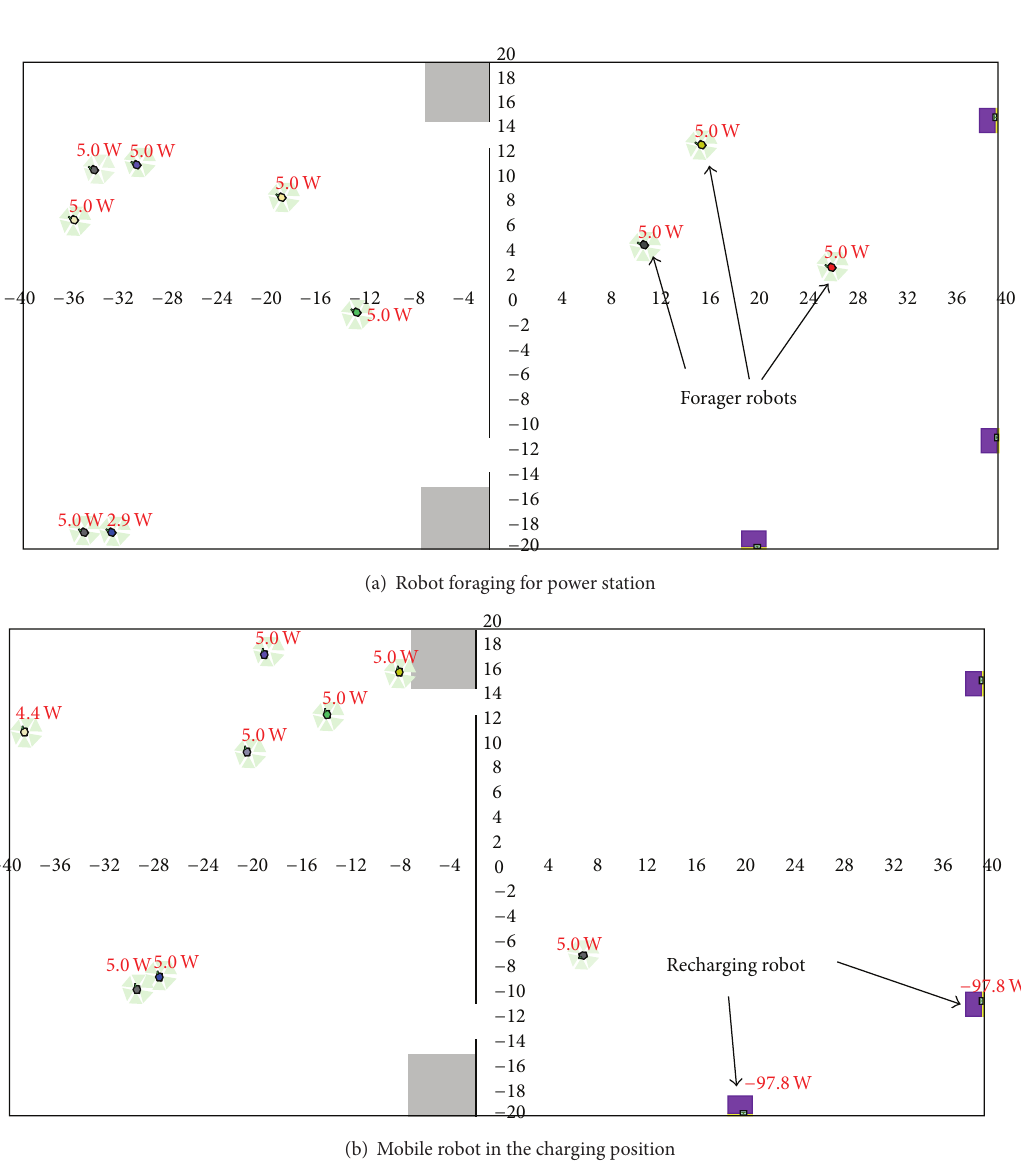
Figure 3: Some of mobile robots in stage of (a) foraging for power station (b) recharging at power station B and C.